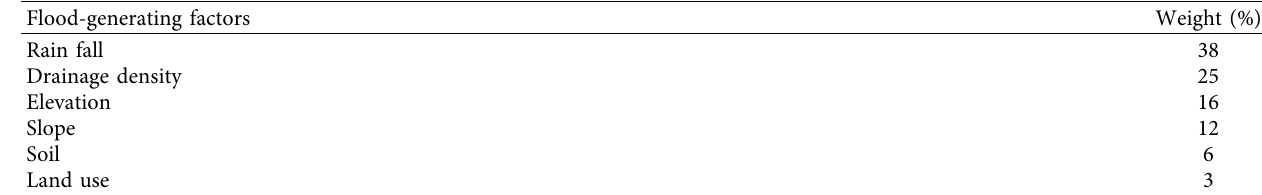
Table 5: Weight of food-generating factors after paired wise comparisons of AHP.